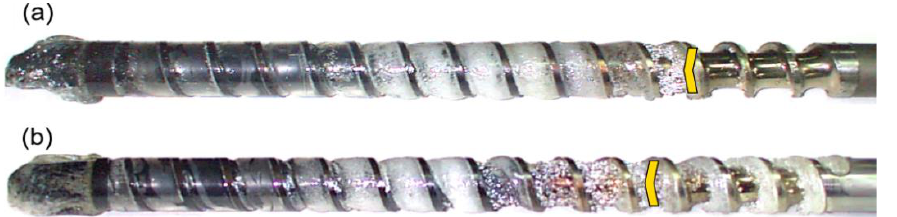
Figure 13. An effect of the plastication stroke on the polymer flow in the injection molding process at the screw speed N = 300 rpm, and the back pressure P back = 0 MPa: ( a ) h plast = 1 D, ( b ) h plast = 3 D.